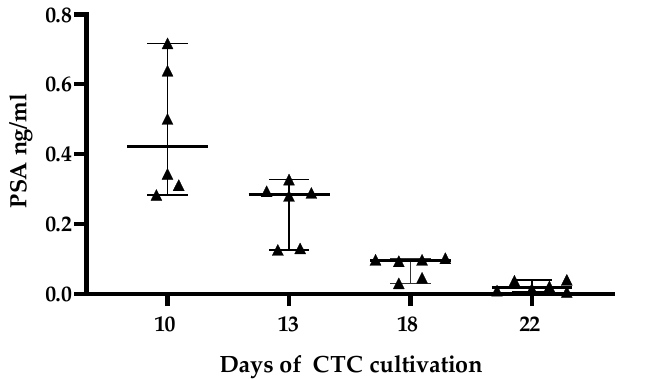
Figure 7. Concentration of PSA in ng/mL of cultivated CTCs in the supernatant displayed as median with range. CTCs were successfully cultivated in different single-cell culture wells of a 24-well plate. CTCs originated from a single patient.